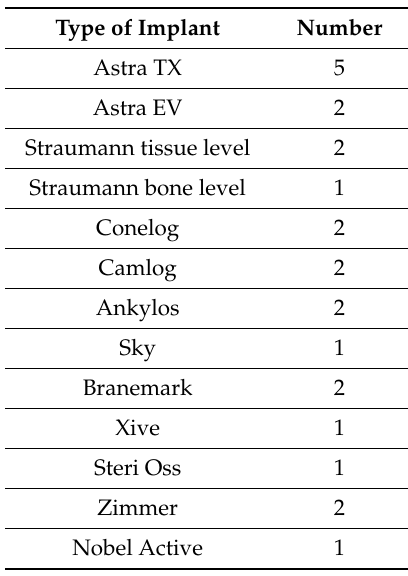
Figure 6. Boxplot indicating the merged distribution of the assessment points in EC and PEC. 230 Table 3. Allocation of di ff erent implant